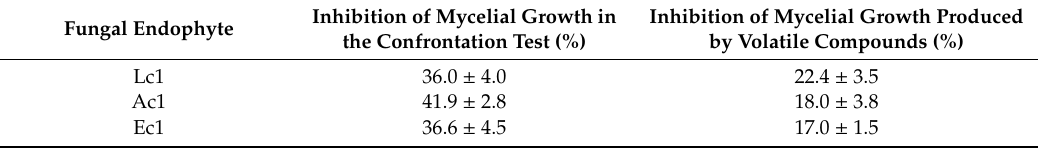
Table 2. Effect of endophytic fungus on B. cinerea mycelial growth in confrontation assays and by volatile compounds.